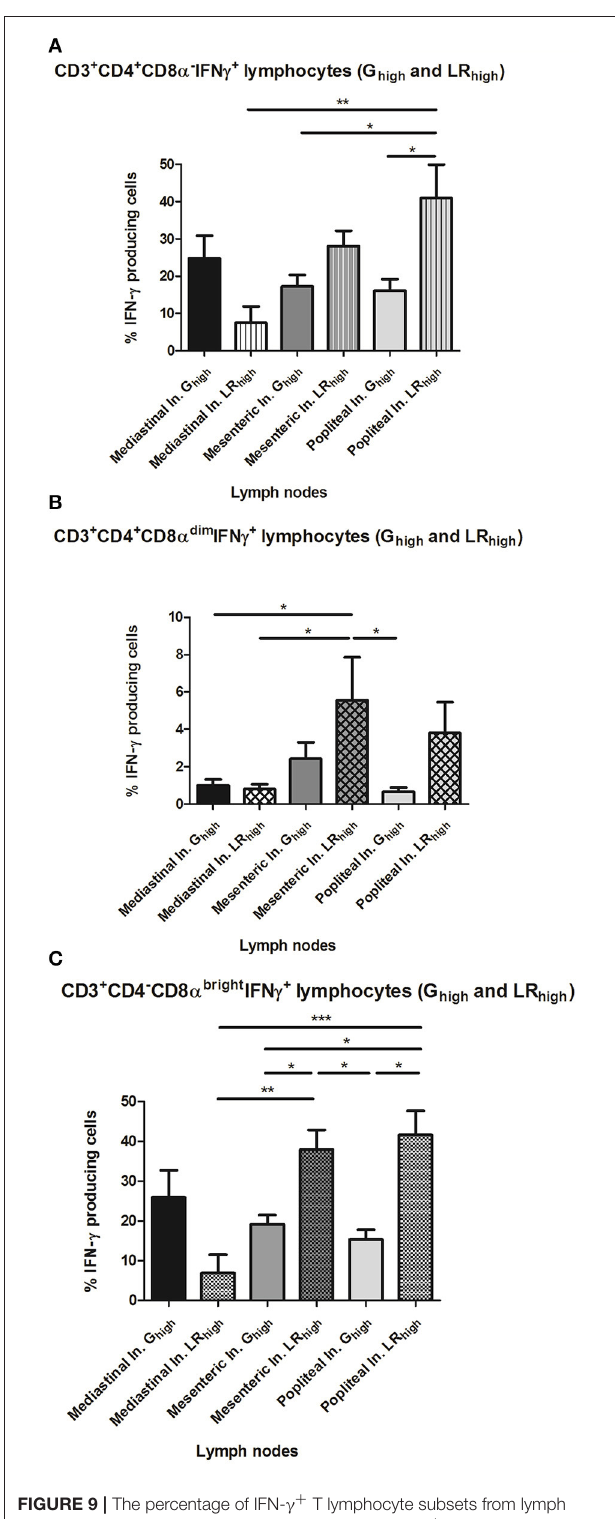
FIGURE 9 | The percentage of IFN- γ + T lymphocyte subsets from lymph nodes after a single IPB-G or IPB-LR inoculation. IFN- γ + T lymphocyte subsets in leukocytes from peripheral lymph nodes of pigs 98 dpi with a high dose of the IPB-G (G high ) or the IPB-LR strain (LR high ). Cells were